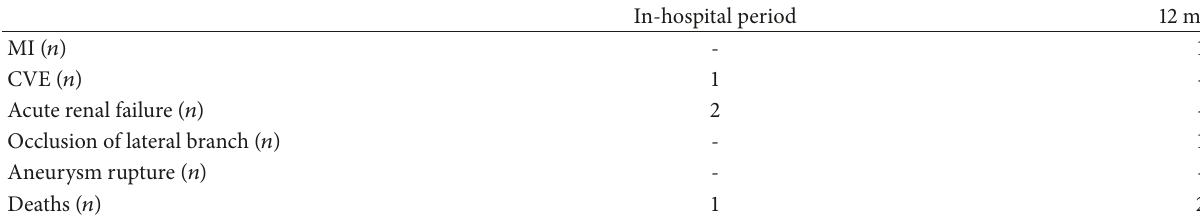
Table 3: Undesired clinical events during in-hospital treatment and 12-month follow-up period.